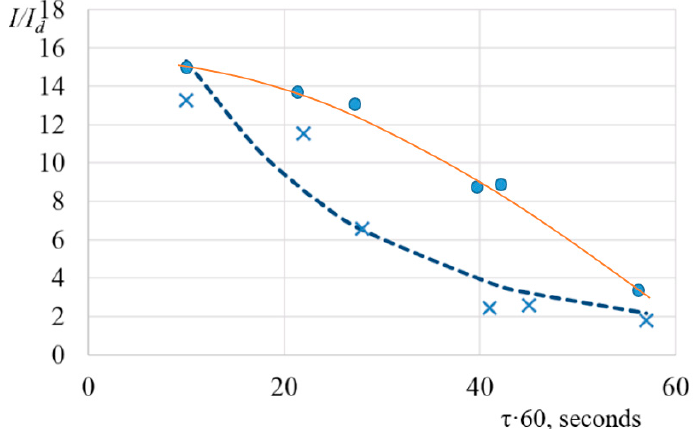
Figure 4. Increases in the intensity of mass transfer between propane and water when a high-speed mixer is used, compared to free diffusion mode: × -fixed interphase surface; - mixer rotation speed is 92 rpm.